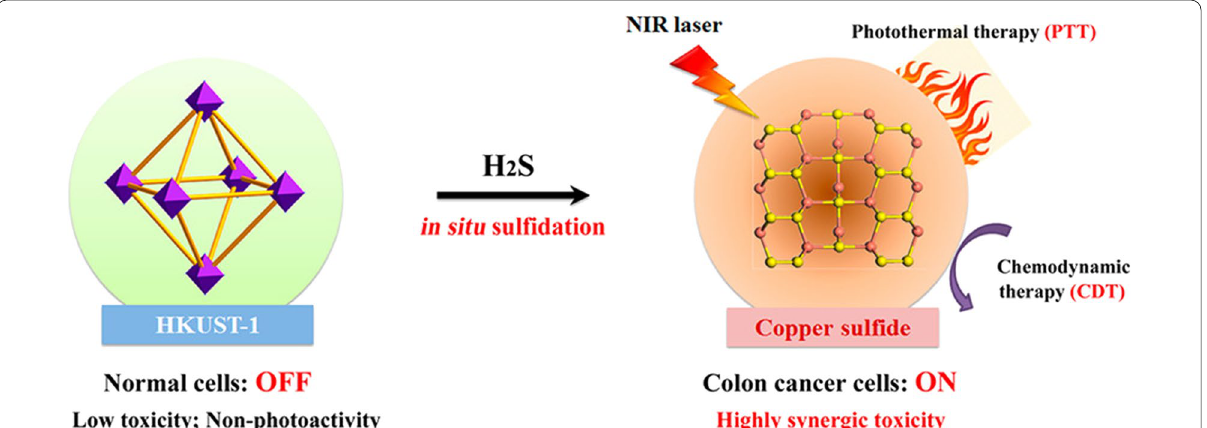
Fig. 5 Schematic Illustration of the H 2 S-Triggered Transformation of Non-photoactive Cu-MOFs Nanoenzyme into an Near-NIR-Activatable Photothermal Agent by in Situ Sulfifidation Reaction and Its Further Synergic Photothermal and Chemodynamic Therapy for Colon Cancer